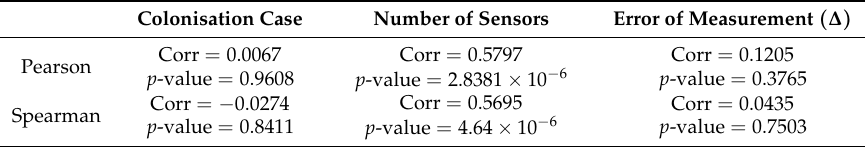
Table 11. Correlation between metrics for a and inputs of